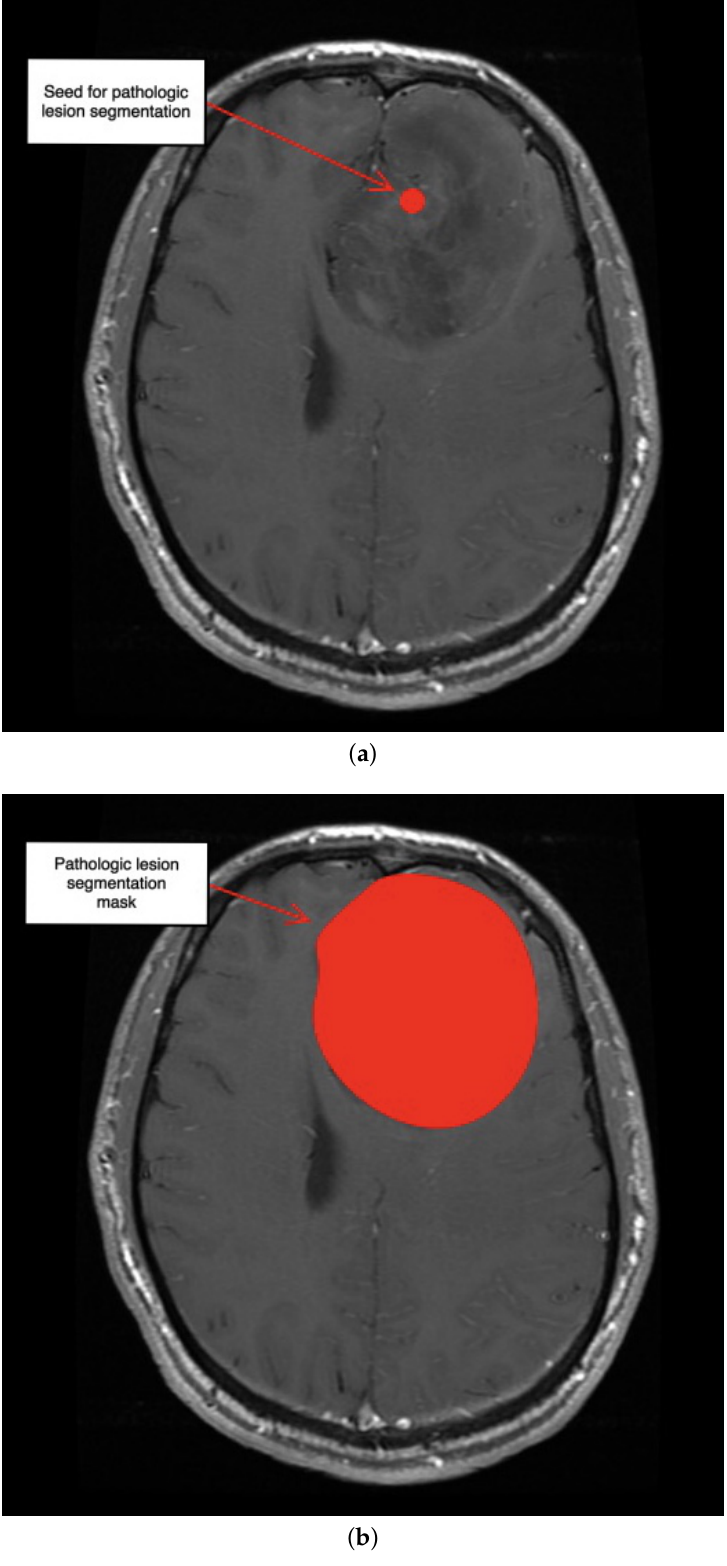
Figure 12. Experimental assessment, third patient. Segmentation with the proposed methodology ( a ) seeds localization, ( b ) results of the segmentation process, the red area indicated by SVM represents the pathologic